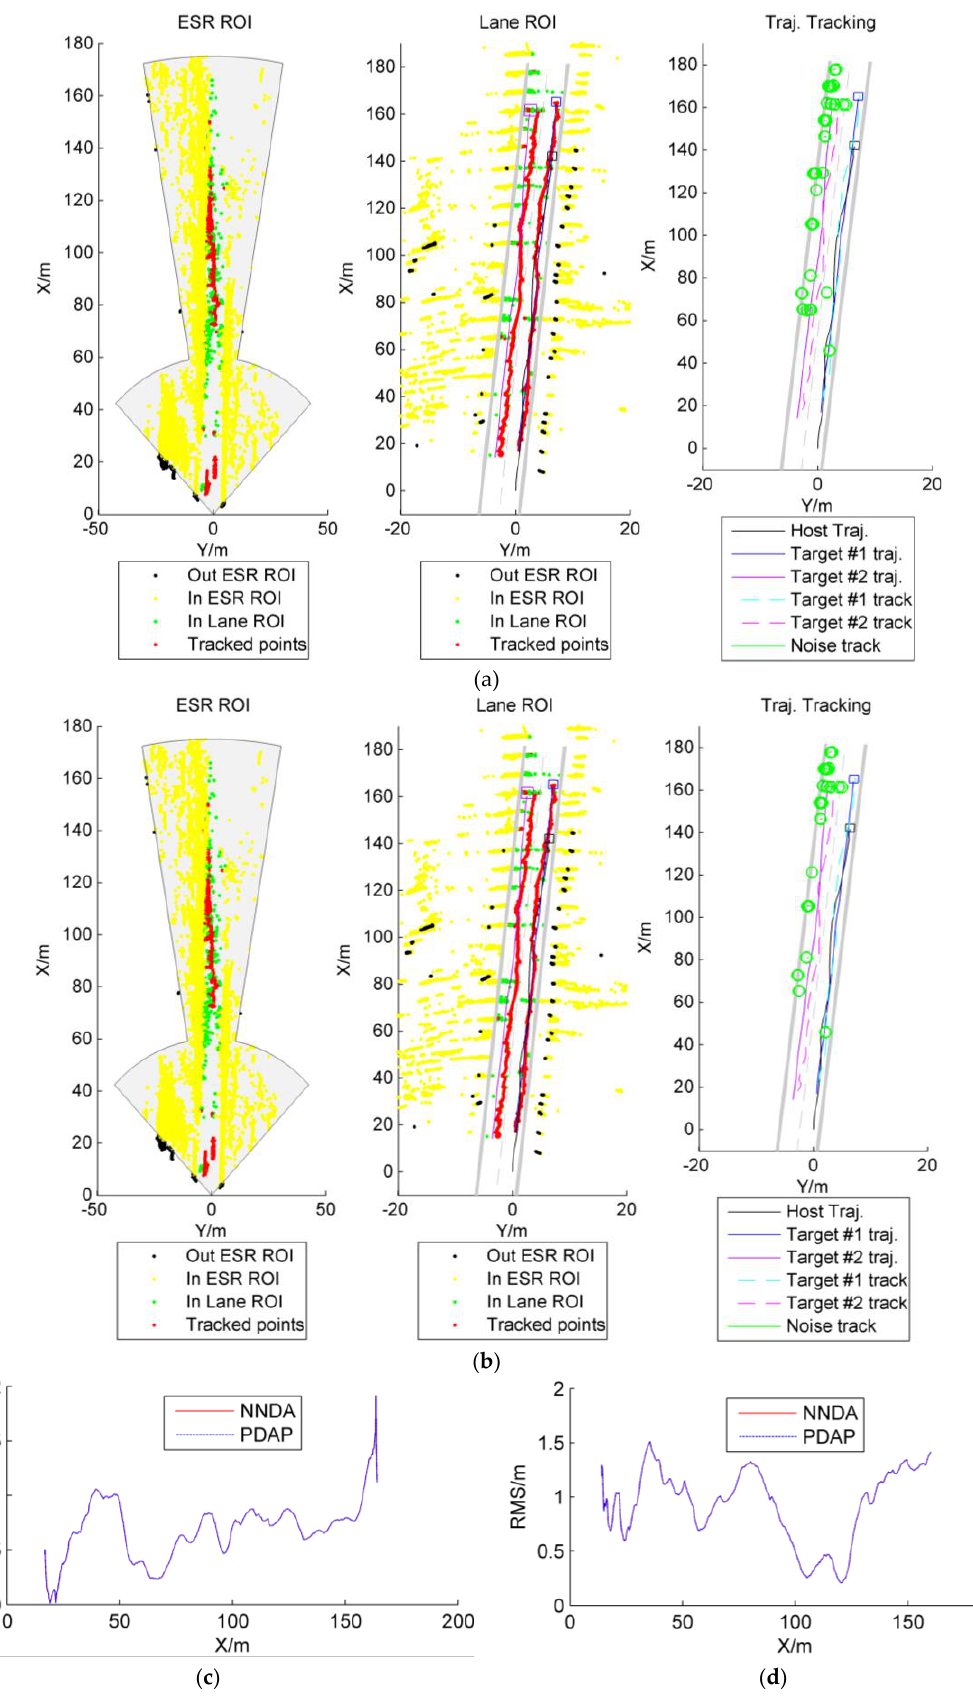
Figure 7. Real test for scenario 3. ( a ) NNDA-CT-UKF multitarget tracking; ( b ) PDAP-CT-UKF multitarget tracking; ( c ) RMS for tracking target #1; ( d ) RMS for tracking target #2.